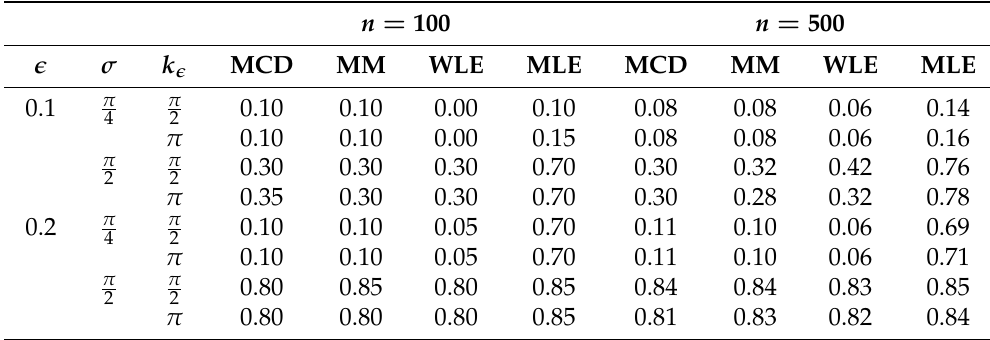
Table 2. Median values of type–II error rate for p = 2 and α =